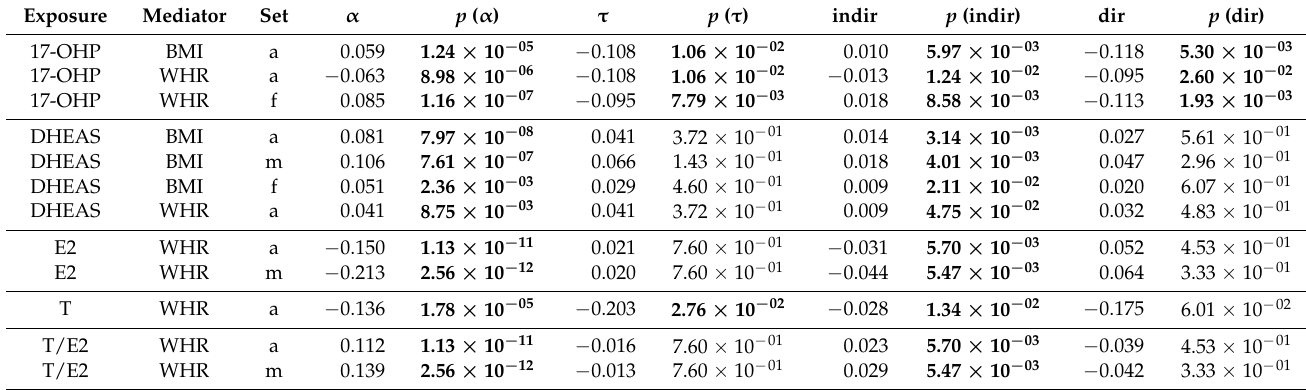
Table 4. Results of Mendelian randomization and mediation analyses of steroid hormones on CAD via obesity-related traits. First, the causal effects of the steroid hormones on the obesity-related mediators are provided (“ α ”). Then, the causal effects of the hormones on CAD are provided (“ τ ”). The indirect effect (“indir”) is the product of α and the causal effect of the obesity-related mediator on CAD taken from Zhang et al. [20]. Finally, the direct effect of the steroid hormone on CAD is calculated as the difference between τ and the indirect effect (“dir”). Significant causal effects are displayed in